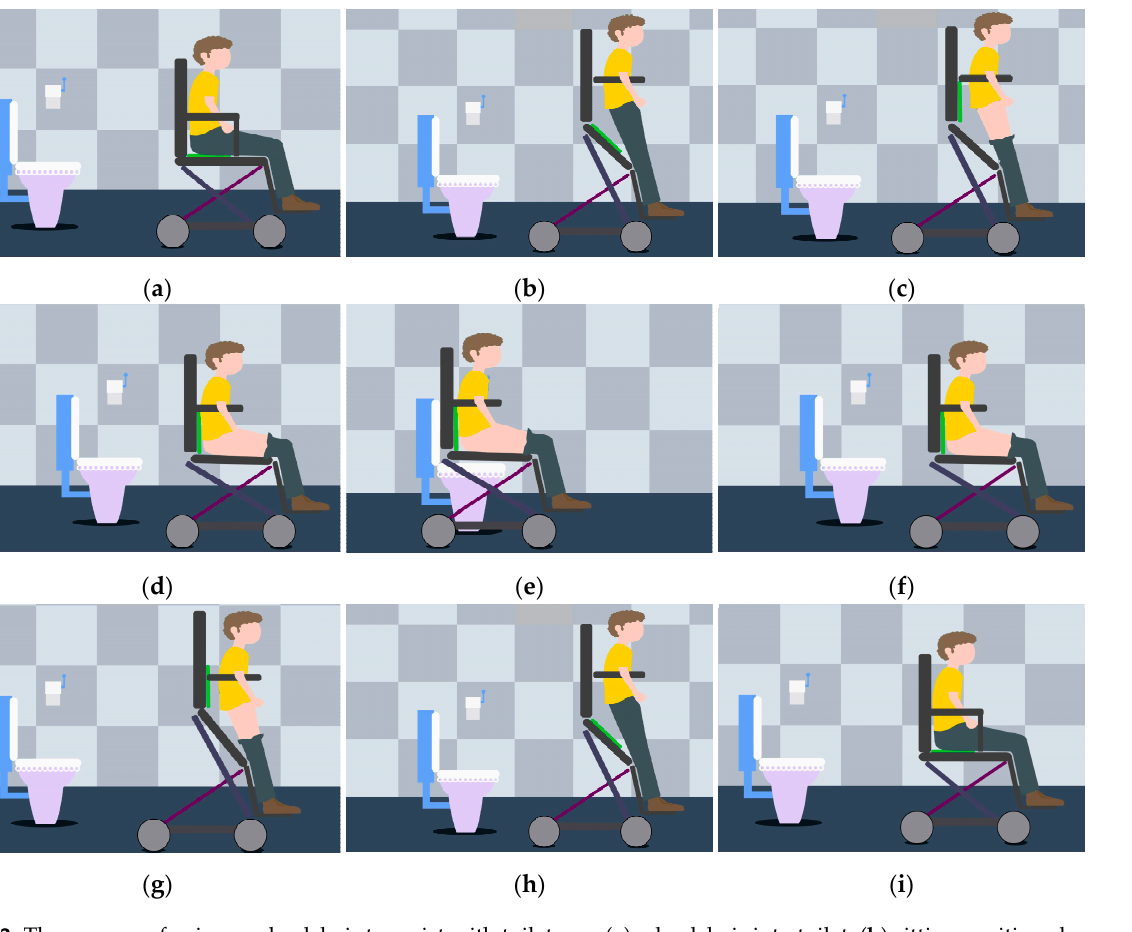
Figure 2. The process of using a wheelchair to assist with toilet use: ( a ) wheelchair into toilet; ( b ) sitting position changes to standing position; ( c ) preparation before going to the toilet; ( d ) from standing to sitting; ( e ) wheelchair sits astride the toilet; ( f ) wheelchair away from toilet; ( g ) sitting position changes to standing position; ( h ) fix clothes after using the toilet; ( i ) wheelchair pulled out of the bathroom.